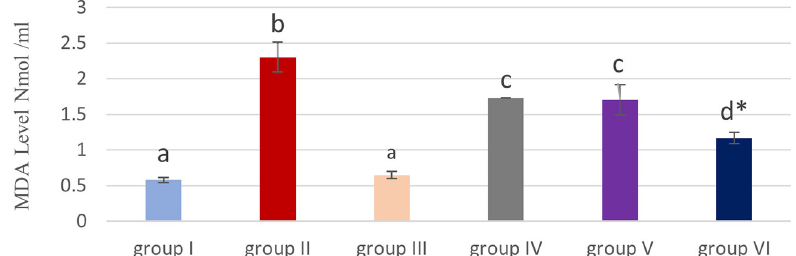
Figure 2. Showing effect of cyanocobalamin on malondialdehyde (MDA) contents in the kidney tissue homogenate of rats. - Each value represents mean (cid:3) standard error of means (SEM) (N=7/Group), - Values expressed in non-identical letters (a, b,c ,d) are significantly difference (P<0.05), - *Highly significant difference from MTX P<0.01.